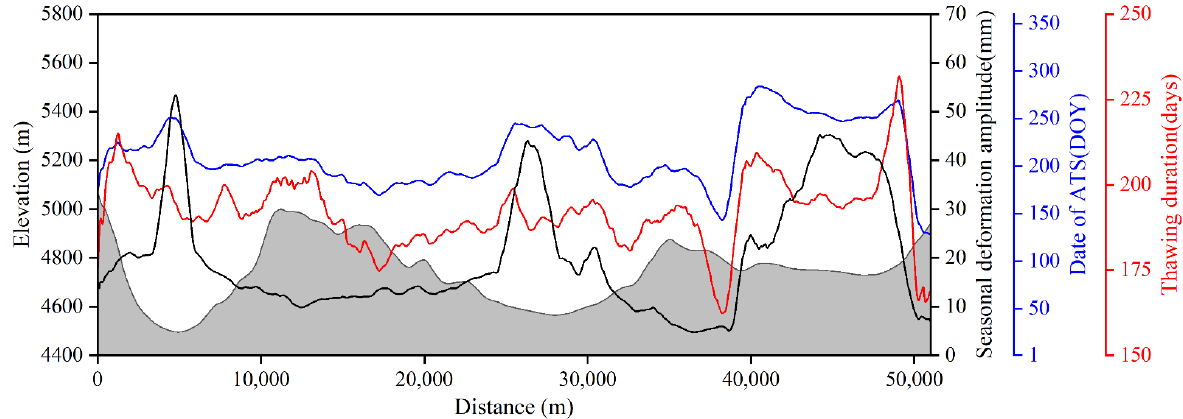
Figure 8. The relationship between SDA and time characteristics of seasonal deformation at the selected profile line P-P’ (Figure 1). Table 4. The correlation coefficient between seasonal deformation